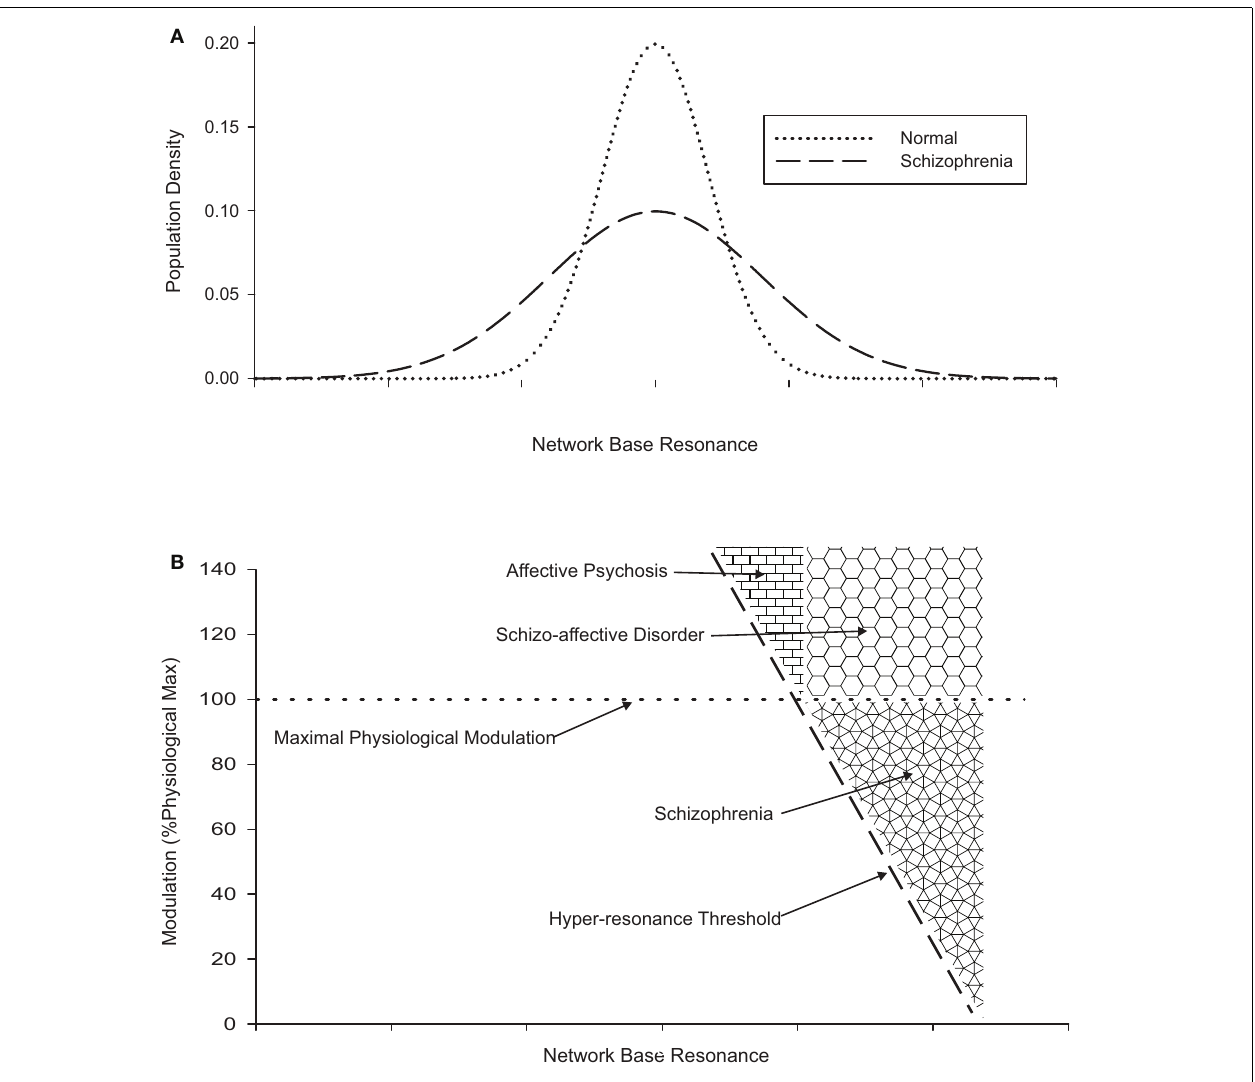
FIGURE 1 | (A) (Top) showing the effect of greater hodological variance on network base resonance in schizophrenia. (B) (Bottom, using same x -axis) showing the relationship between network base resonance, modulation, and hyper-resonance, and the relationship between schizophrenia, schizo-affective disorder, and affective